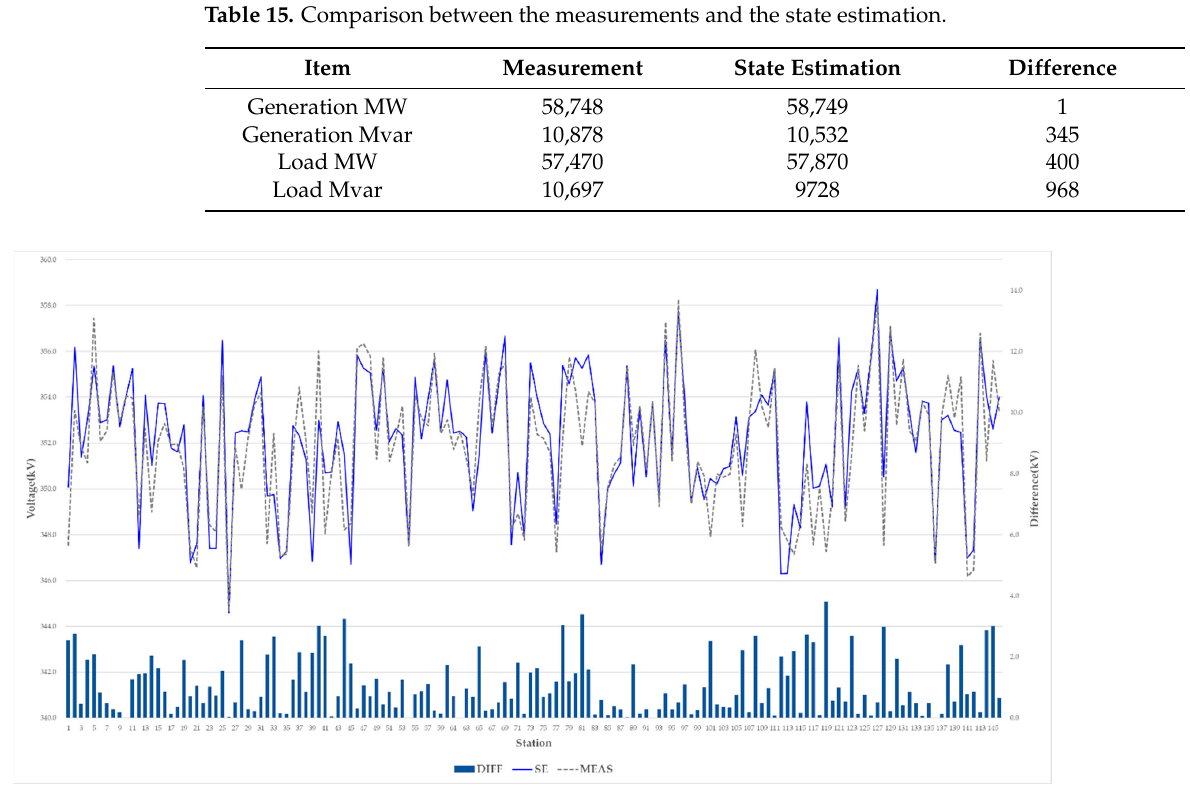
Figure 11. Voltage magnitude of a 345-kV bus for the estimation results and measurements.